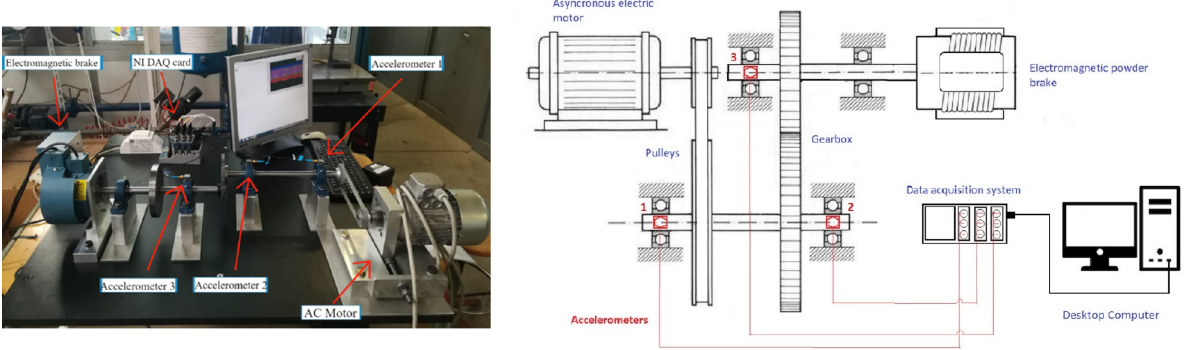
Figure 6. The test rig ( left ) and its mechanical scheme ( right ).